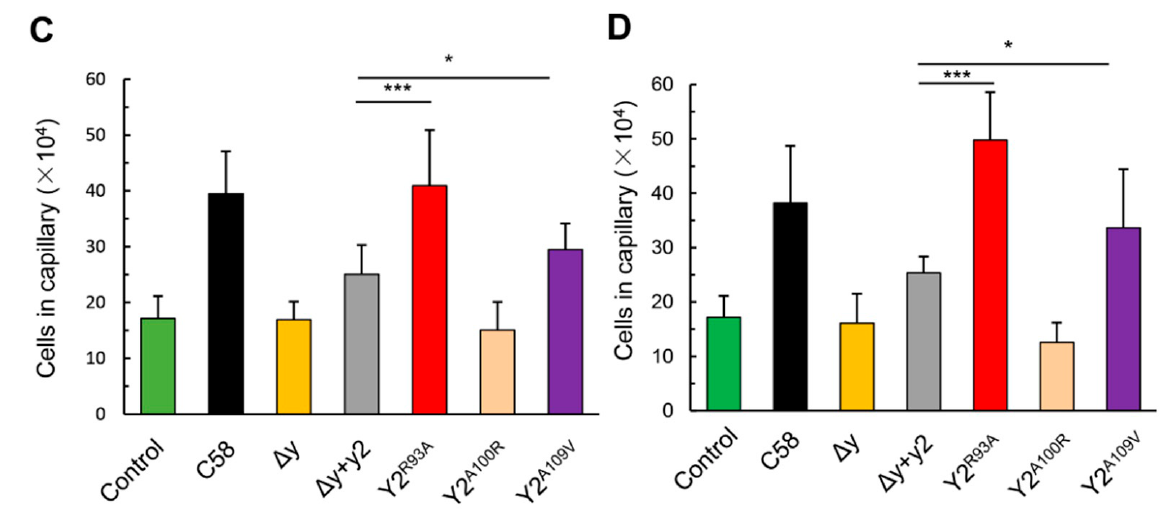
Figure 6. Effects of CheY variants on the chemotactic response of A. fabrum to host plant attractants and a single attractant. A leaf disc of kalanchoe was placed on the center of the plate to generate an attractant concentration gradient. Equal amounts of various A. fabrum cells were inoculated around the leaf disc with equal distance from the leaf disc and incubated for 40 h at 28 ◦ C. The distance from the inoculating spot to the edge toward the leaf disc (L) minus the distance from the inoculating spot to the edge away from the leaf disc (N) was defined as the relative migration distance, which was used to assess the chemotactic response of A. fabrum to host attractants. ( A ) Typical colonies of the tested A. fabrum strains. ( B ) Relative migration distance of these strains. ( C ) Cells migrating into the capillary containing sucrose. ( D ) Cells migrating into the capillary containing AS. Data show the means of three biological replicates with the standard deviations. The bars connected by “*”, “**” and “***” mark mean that they are different in a statistically significant manner at p < 0.05, 0.01 and 0.001, respectively via the unpaired Student’s t test. The strains represented by the labels are the same as in Figure 5. Control indicates C58 cells migrating into the capillary containing buffer only.